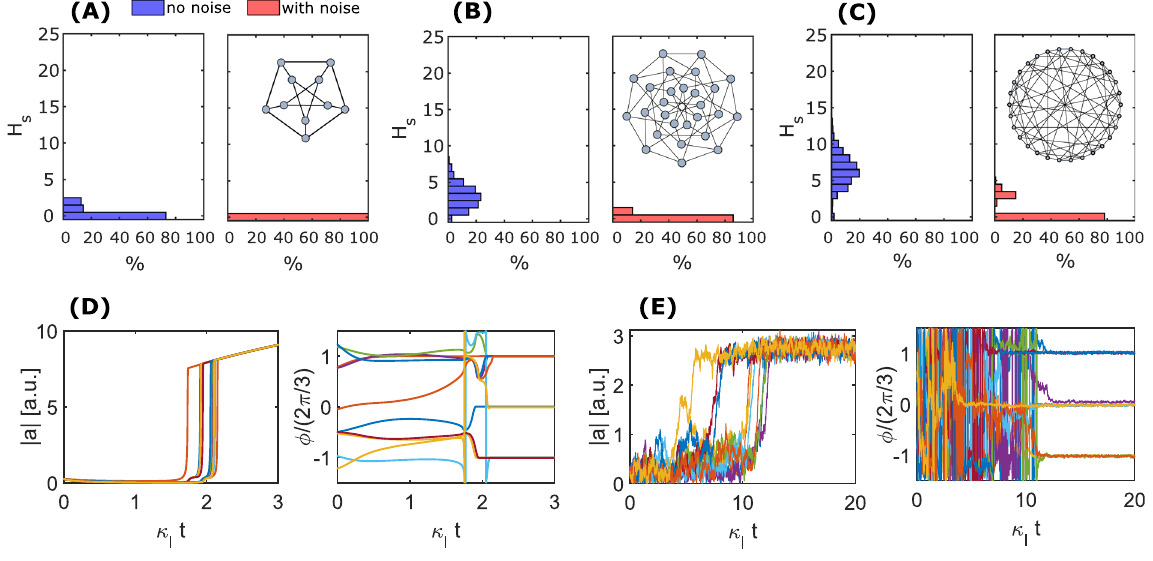
Figure 3: Examples of graph three-coloring using the proposed Potts machine without and with noise. (A – C):Distributionofthesteady-stateenergy H s (cid:1) ∑ 〈 ij 〉 δ ( θ i , θ j ) calculatedfor1000randominitializations,withoutnoise(blue)andwithnoise (red), for (A) a three-regular graph with 10 vertices (Petersen graph), (B) a four-regular graph with 27 vertices (Doyle graph), and (C) a fi ve- regulargraphwith30vertices(Meringergraph).Thesegraphsareallthree-colorable.(D,E)Timeevolutionoftheamplitudesandphasesofthe Peterson network without and with noise, respectively. In these simulations, κ mn (cid:1) κ (cid:1) 1 , g s (cid:1) 0 . 1 and κ l (cid:1) 1, while the gain is increased linearly with the slope of 20 g th κ l for (D), and 0 . 1 g th κ l for (E). The noise is taken to be uncorrelated for different oscillators and with uniform amplitude and phase distributions in the ranges of [ 0 , 0 . 1 ] and [ 0 , 2 π ] ,